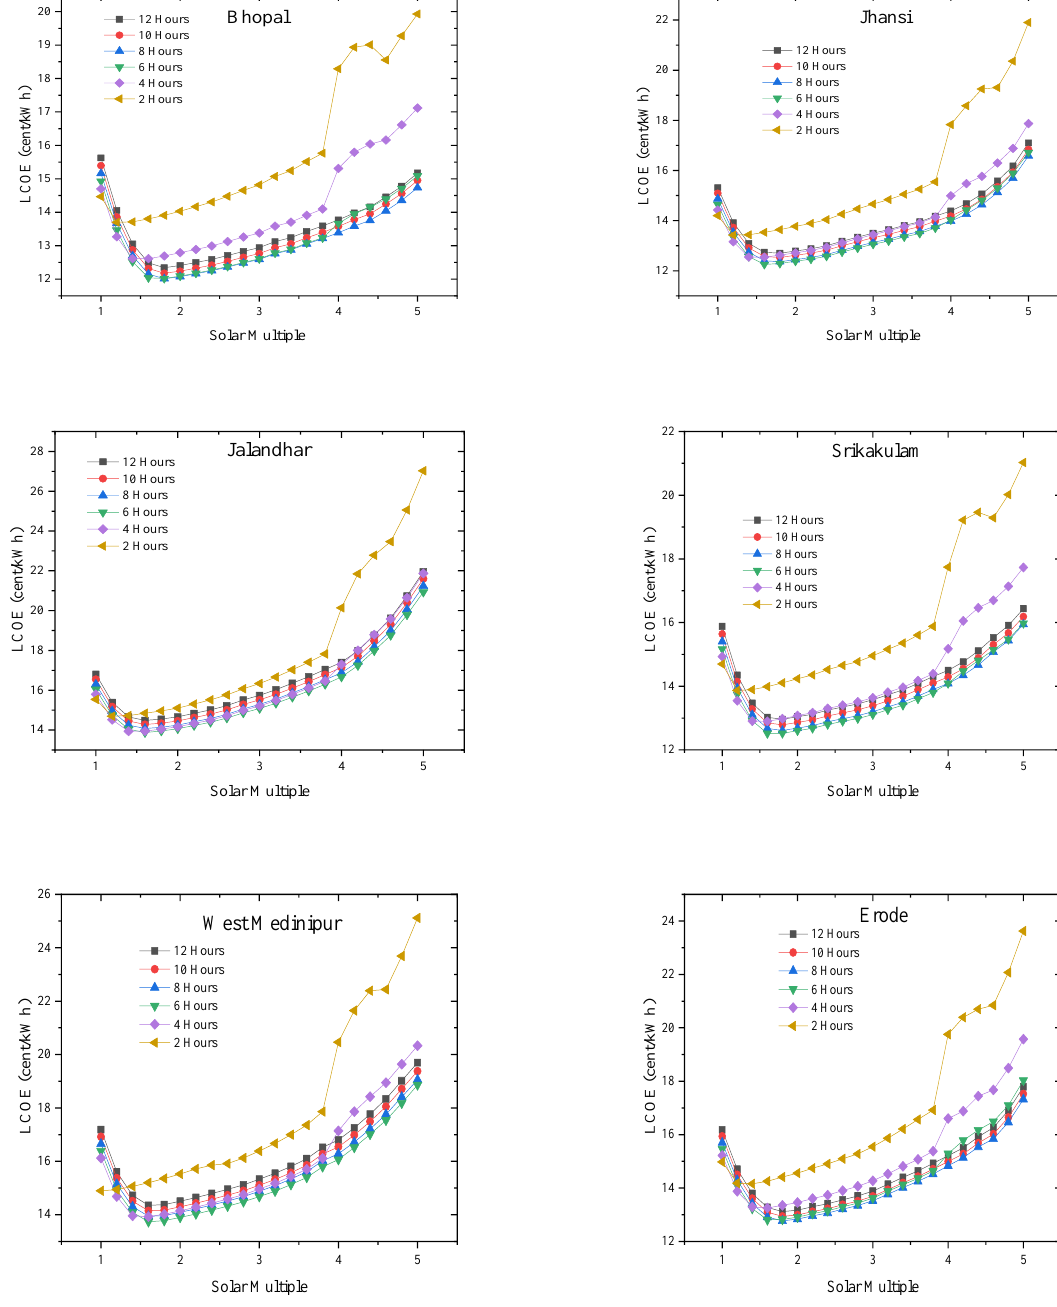
Figure 6. Effect of SM and TES on the LCOE (dry-cooled model) in different cities of India. 3.3. Electric Generation Analysis of STPP (Wet-Cooled) Plant at Six Potential Sites in India Figure 7 shows the total electric generation power output for the STPP wet-cooled model at the selected sites. The output performance of the wet-cooled model is not significantly different from the dry-cooled model presented supra. The major drawback of utilizing the wet-cooled STPP model is that it consumes more water compared to the dry-cooled STPP model. However, the annual maximum electric energy power output is higher for the wet-cooled STPP as compared to that of the dry-cooled STPP.